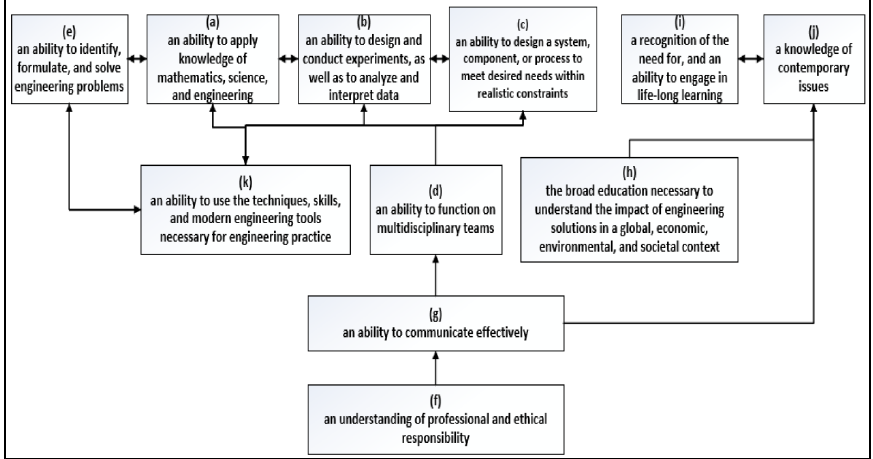
Fig. 3. Proposed Study Plan Using